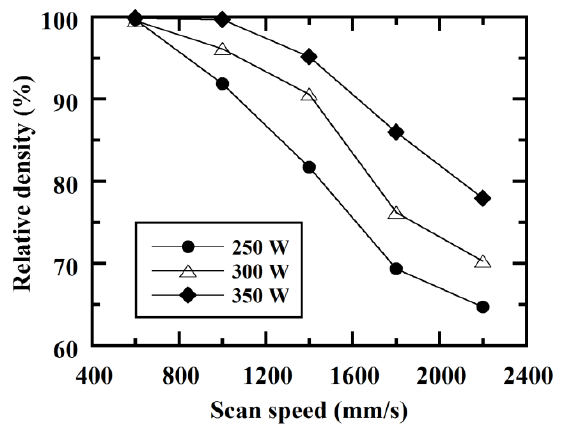
Figure 4. Relative density of C/Al SLM composites as a function of laser scan conditions of laser power and scan speed.